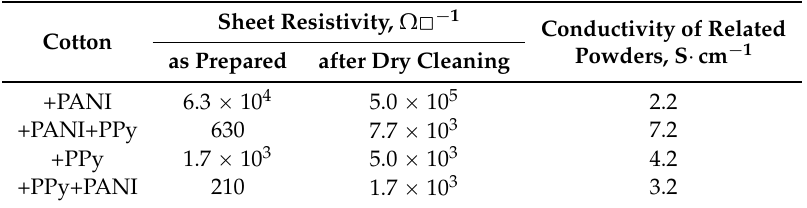
Table 1. Sheet resistivity of cotton fabric coated with conducting polymers and the conductivity of such polymers.